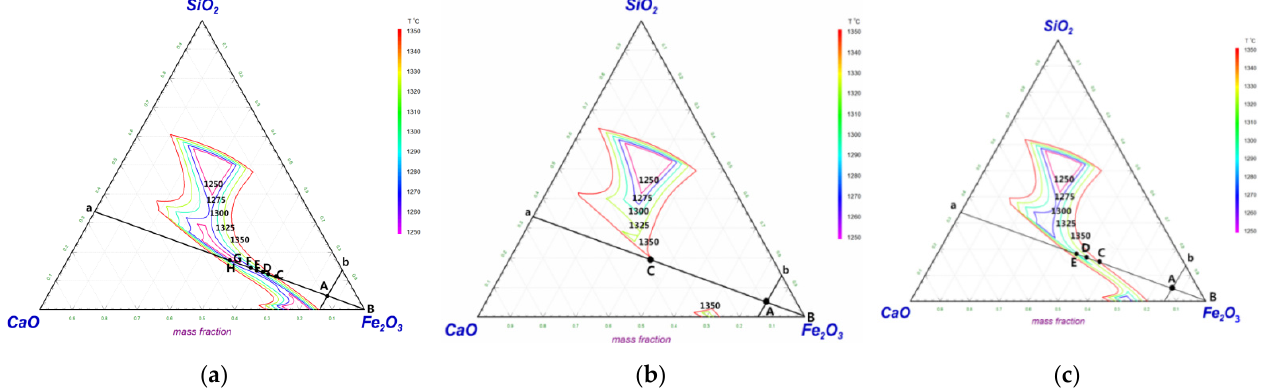
Figure 5. Liquid region of the CaO ‐ SiO 2 ‐ FeOx ‐ Al 2 O 3 ‐ MgO system. ( a ) MgO content of 1.0%; ( b ) MgO content of 2.0%; ( c ) MgO content of 3.0%.